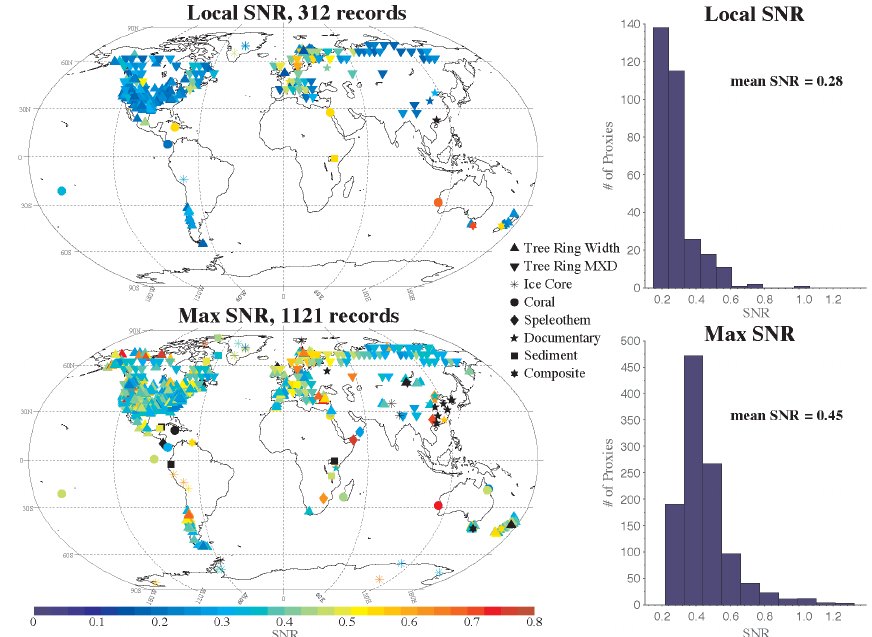
Fig. 3. Estimated signal-to-noise ratio (SNR) for proxies in the M08 network. Top panel: Local SNR scenario, in which SNR is calculated between each proxy and its closest temperature grid. Bottom panel: max SNR scenario, in which the highest SNR for each proxy is chosen from its correlations with all temperature grids available. Colors reflect the value of SNR assigned to each pseudoproxy, as per Eq.